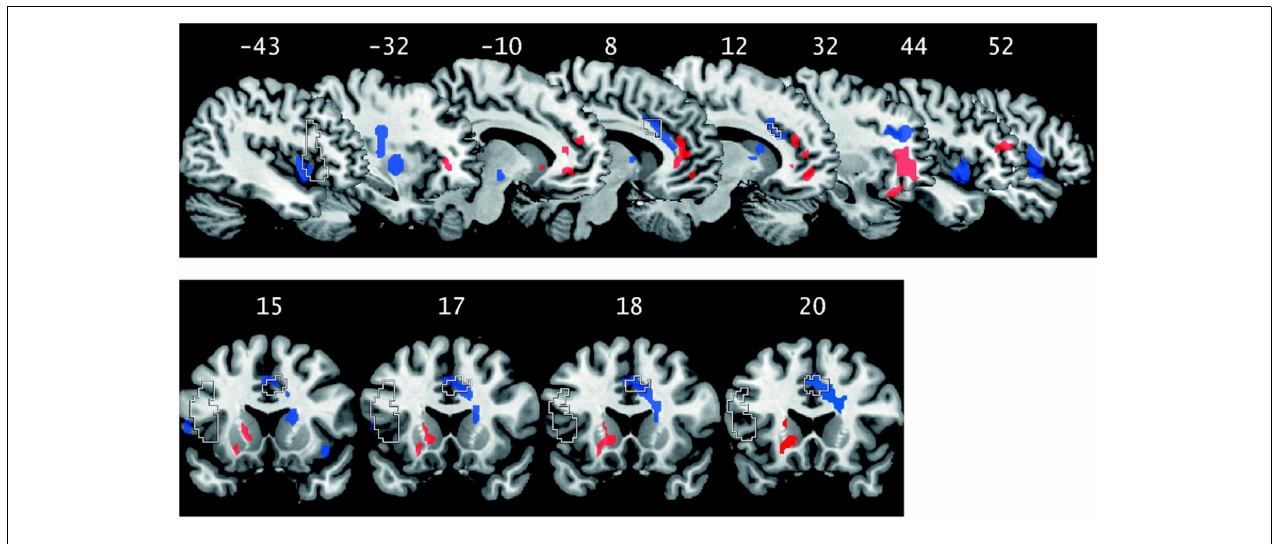
FIGURE 4 | Functional neural changes corresponding with empathy training (red) and compassion training (blue) in comparison to memory control as measured by fMRI (adapted from Klimecki et al., 2014). Dashed lines represent regions